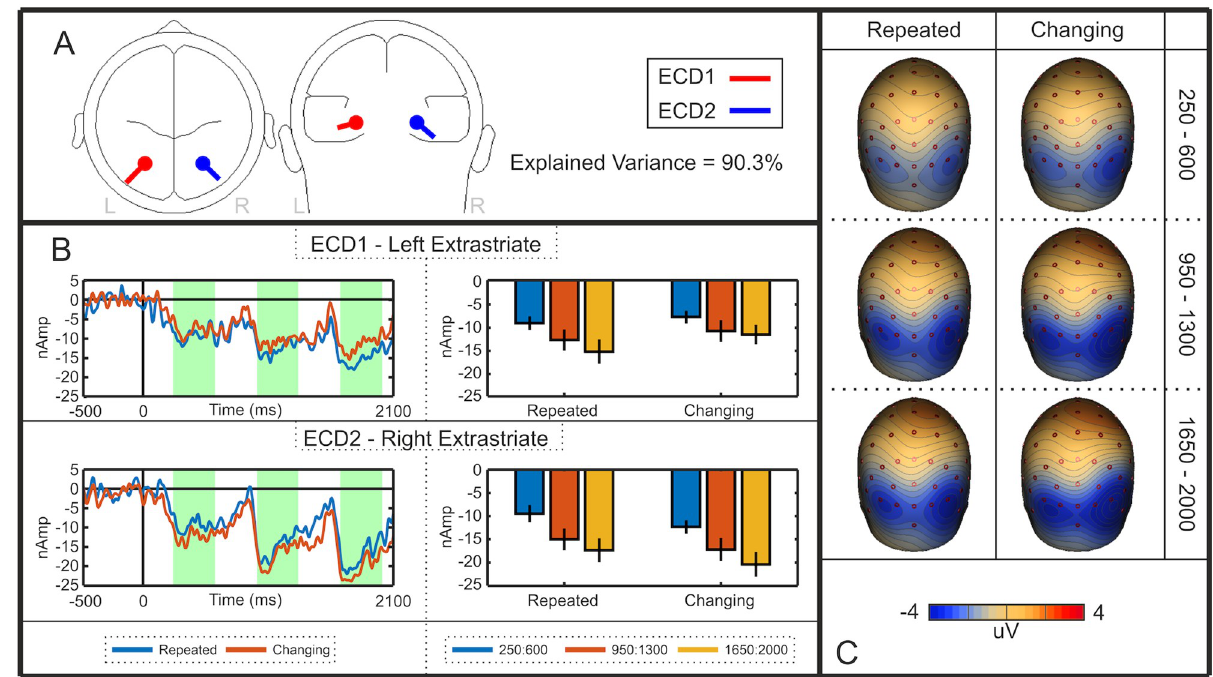
Fig 14. Experiment 5 source dipole model. Note the ubiquitous SPN priming effect in these source waveforms, but right lateralization in the changing regularity condition.